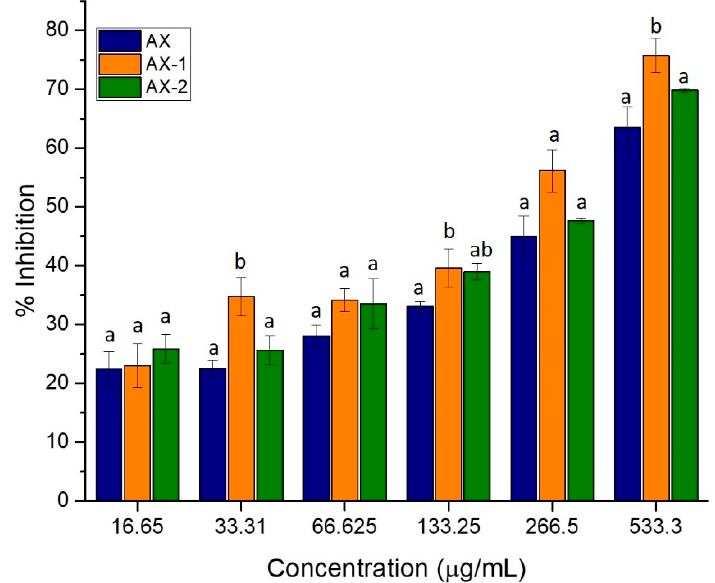
Figure 3. Effect of different conditions of ultrasonic treatment on the antioxidant activity of AX. Untreated AX (AX), AX treated at 25% power for 15 min (AX-1), and AX treated at 50% power for 15 min (AX-2). Values are presented as means ± SD of three replicates. Different letter (a,b) within the same group of concentration indicates a significant difference ( p < 0.05). Table 2. Antioxidant capacity and total phenolic content of AX.